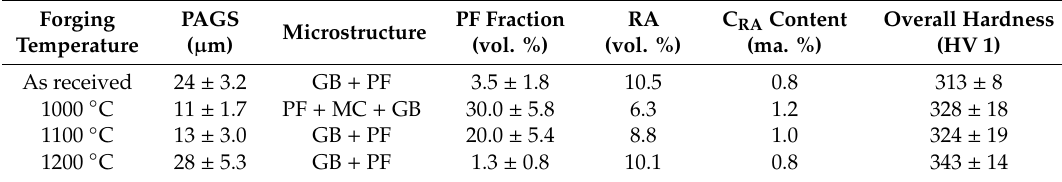
Table 2. Summary of the microstructure